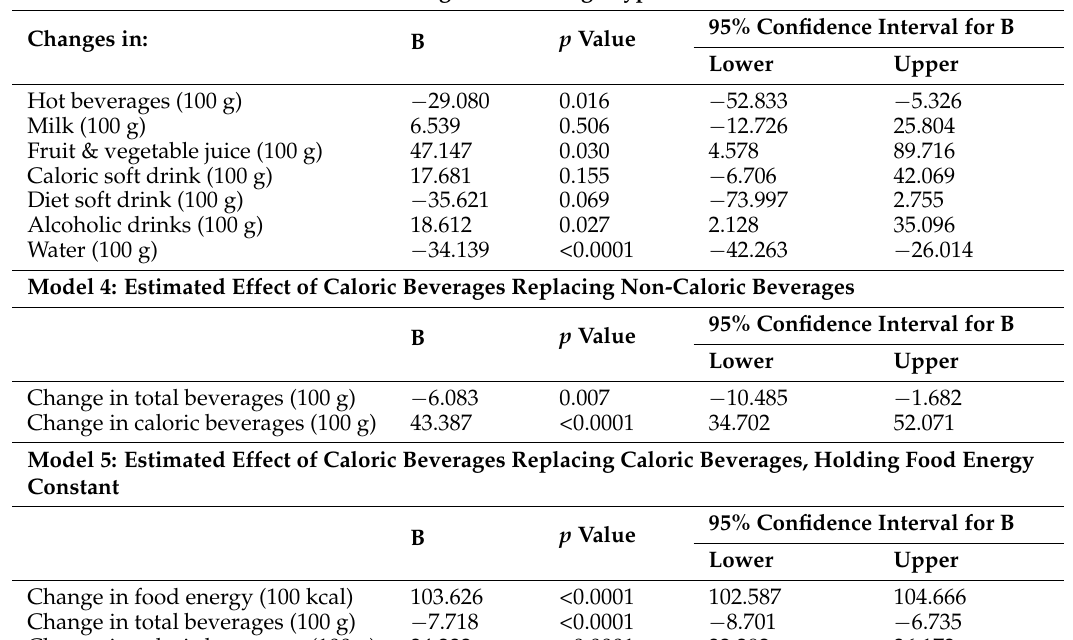
Table A2. Within-person change Model: estimated change in energy intake associated with beverage